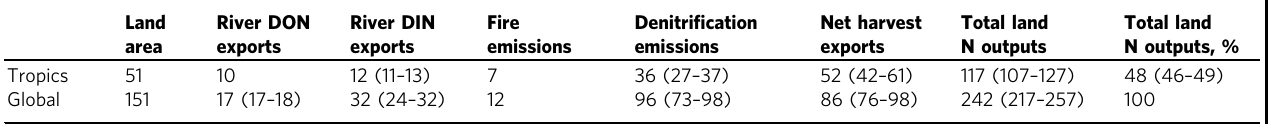
Table 1 Tropical and global land area and N outputs